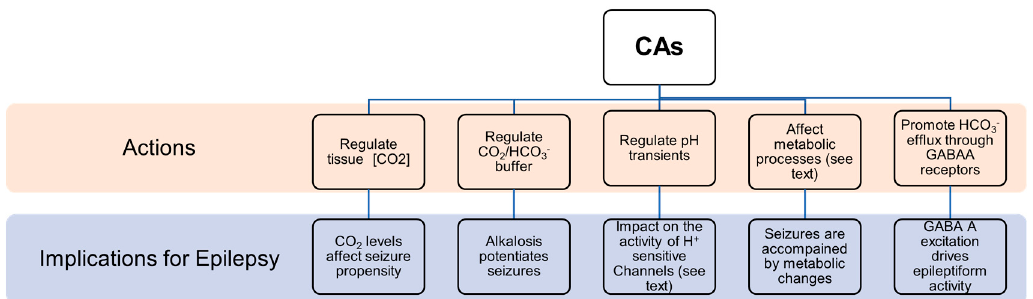
Figure 7. Schematic view of CAs actions and their involvement in epileptic